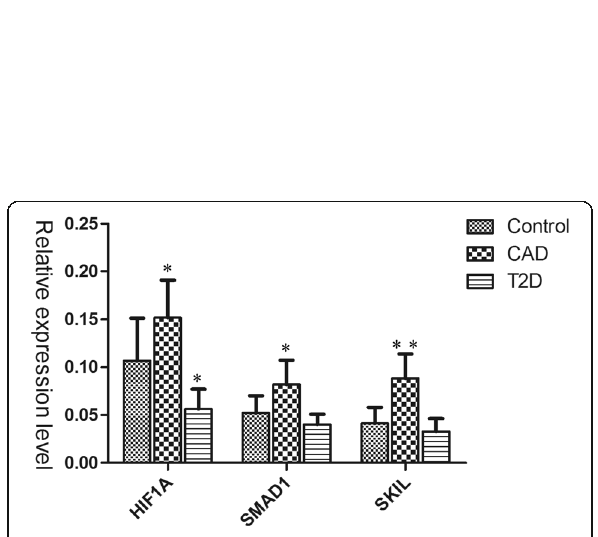
Fig. 3 The verification of mRNA expression of HIF1A, SMAD1, and SKIL in patients with CAD or T2D via